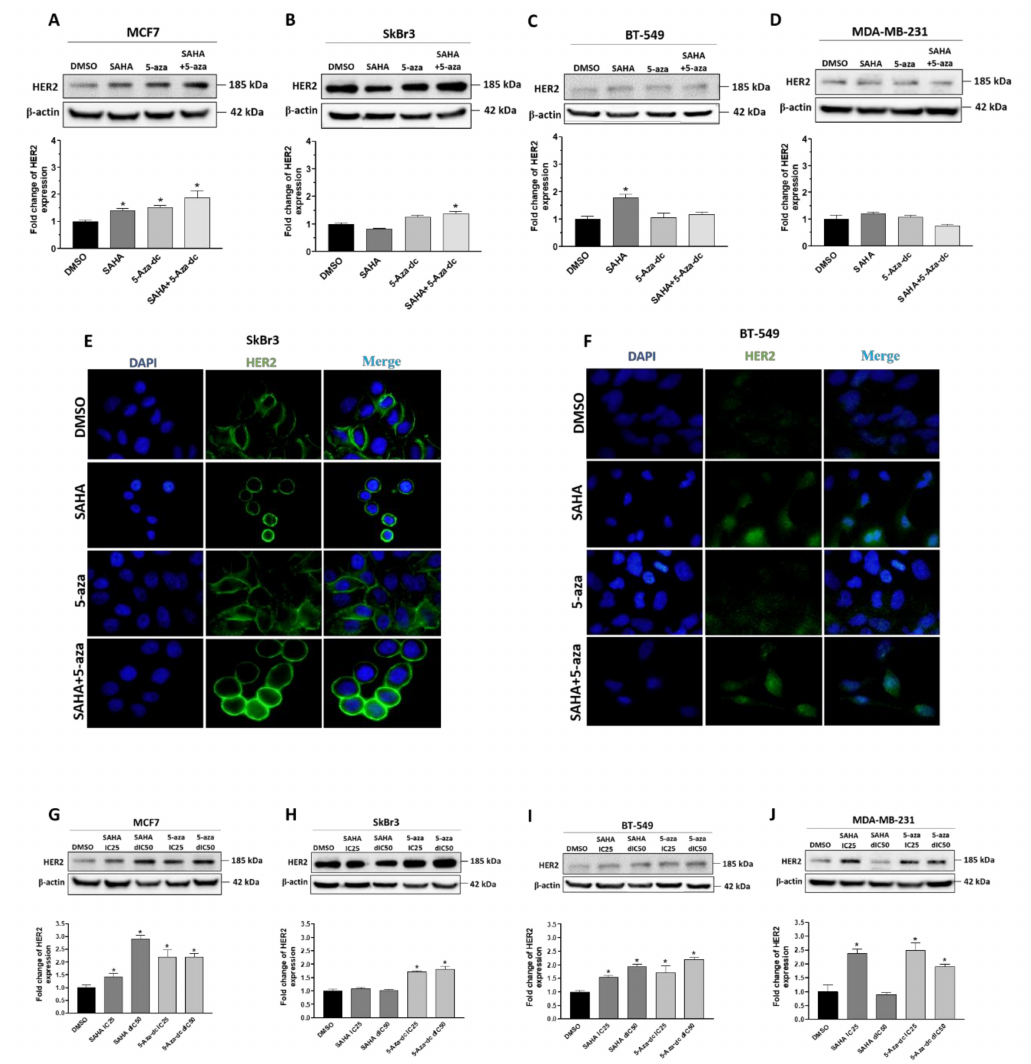
Figure 5. Effect of SAHA, 5-aza-dc and their combination on the expression of HER2/ERBB2 in breast cancer cells. ( A – D ) Western blot analysis of HER2/ERBB2 expression in ( A ) MCF7, ( B ) SkBr3, ( C ) BT549, and ( D ) MDA-MB-231 cells after treatment with the IC50 concentrations of SAHA and/or 5-aza-dc. β -actin was used as a loading control. Lower panels: Bar graphs showing relative fold changes of HER2/ERBB2 expression after quantification and normalization to β -actin expression and DMSO treatment. ( E , F ) Representative micrographs of HER2/ERBB2 (green) and DAPI (blue) fluorescent signals at 100 × magnification in ( E ) SkBr3 and ( F ) BT-549 cells treated with SAHA and/or 5-aza-dc. ( G – J ) Upper panels: Western blots for HER2/ERBB2 expression in ( G ) MCF7, ( H ) SkBr3, ( I ) BT549, and ( J ) MDA-MB-231 cells after treatment with IC25 or double IC50 (dIC50) concentrations of SAHA or 5-aza-dc. Lower panels: Bar graphs showing relative fold changes of HER2 after normalization to β -actin and DMSO treatment. Shown are the means ± SEM of at least three independent experiments. * p < 0.05 versus DMSO